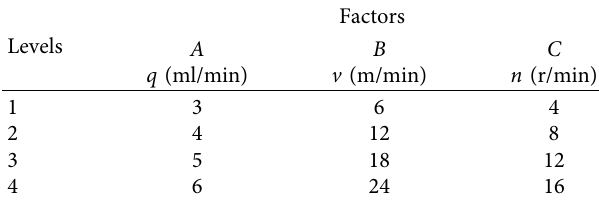
Table 2: Level table of orthogonal test factors.